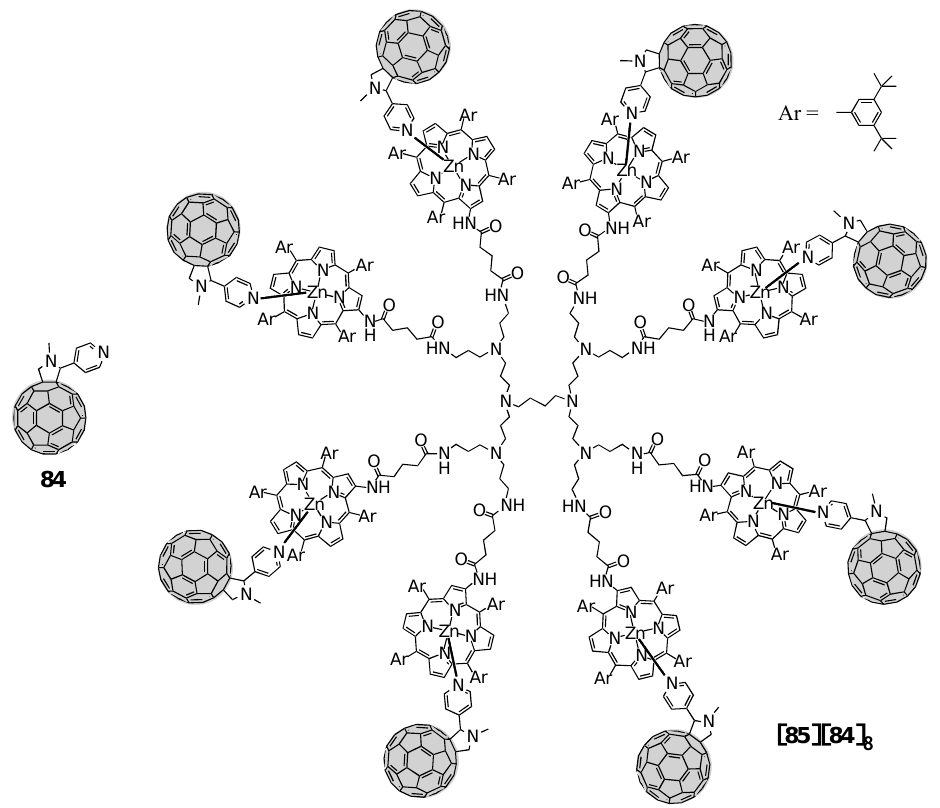
Figure 14. Multiple metal-ligand complexation between polyporphyrin dendrimer 85 and fulleropyrrolidine 84